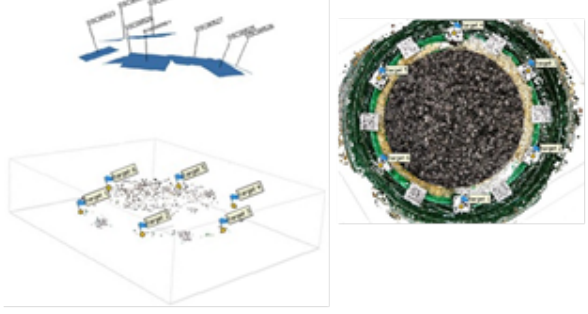
Figure 6. Photogrammetric survey of the surface of an asphalt specimen: on the left images acquisition scheme; on the right an example of the obtained dense point cloud (about 20 million